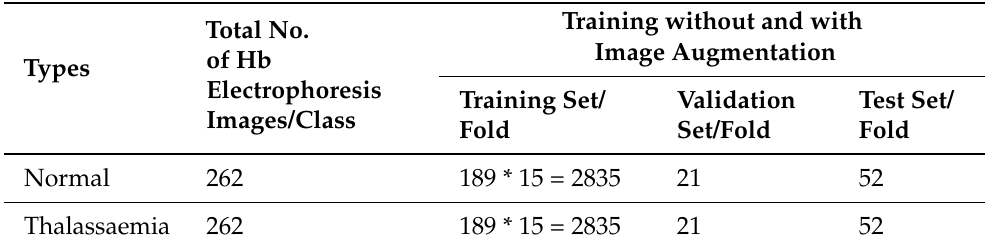
Table 1. Details of training, validation and test sets for classification